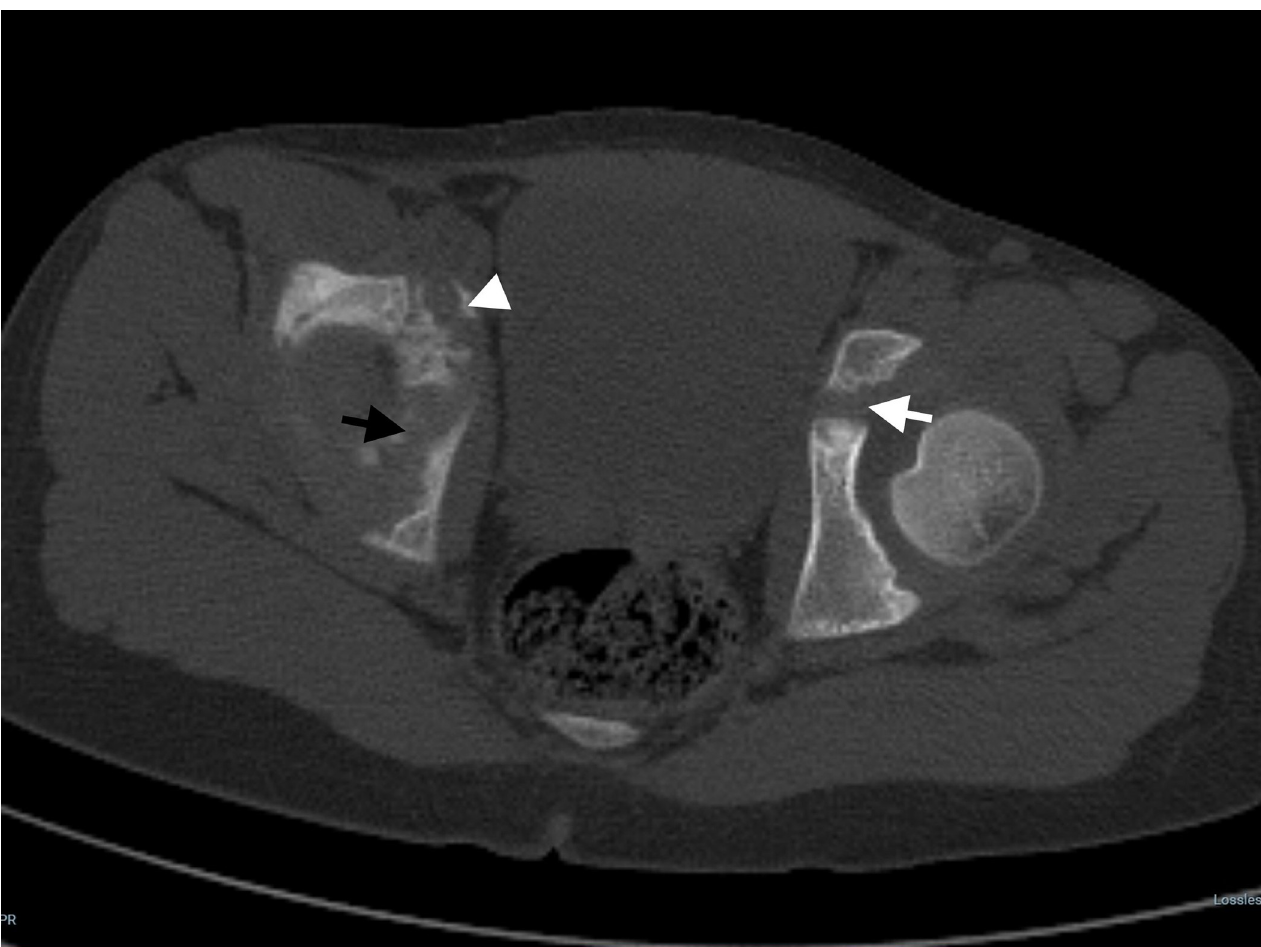
Fig 5. For a patient who is an 8-year-old girl, the axial plane reformatted computed tomography image shows that all three (white arrow: Ischiopubic, black arrow ilioischial, white arrowhead: Iliopubic) synchondrosis regions are open.